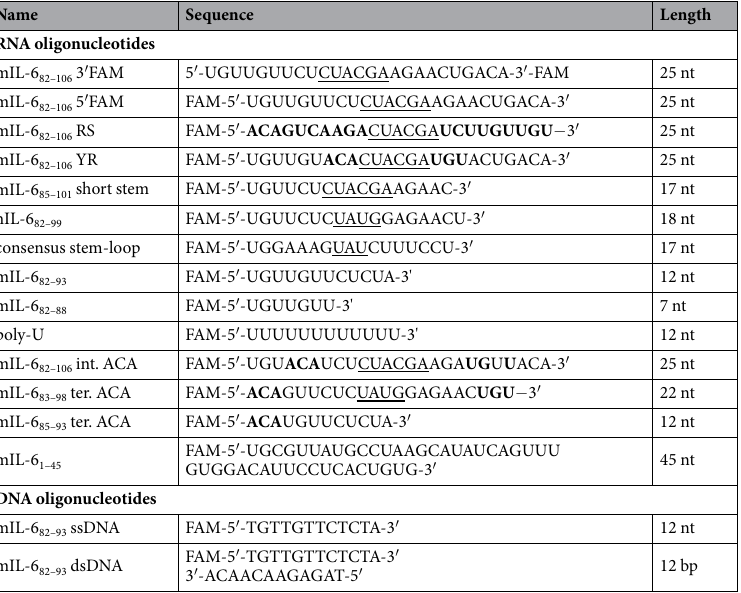
Table 1. Nt sequences of fluorescently modified oligonucleotides used for the RNase assays and affinity determination assays. Nts that form loop fragments of stem-loop structures are underlined. Sequences with numbered residues are part of the 3 ′ UTR of transcripts from mouse or human IL-6. These sequences were numbered such that the first nt after the stop codon of the coding sequence is marked as 0. RS – reverse stem modification of mIL-6 82–106 (altered nts are in bold). YR – purine and pyrimidine residue modification of mIL- 6 82–106 (altered nts are in bold)